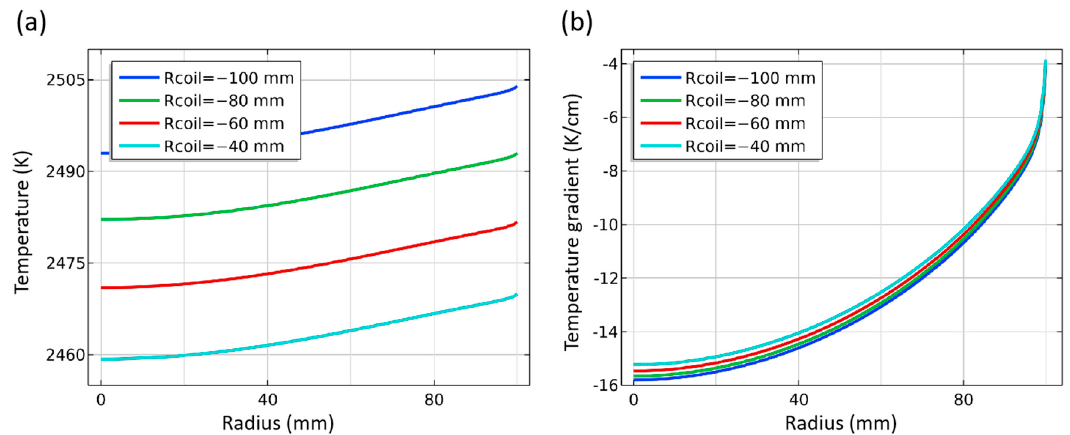
Figure 12. Temperature and temperature gradient at different coils diameter. ( a ) Temperature along surface of seed crystal; ( b ) Temperature gradient around seed crystal.